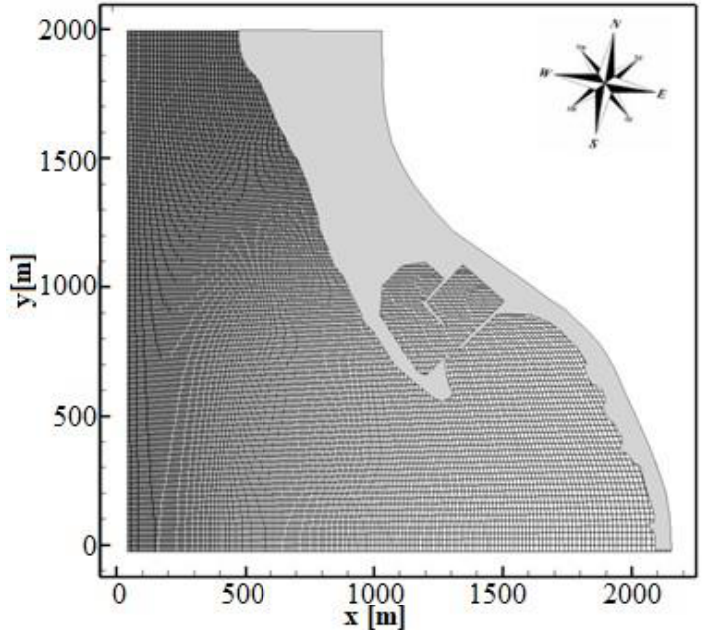
Figure 7. Plan view of the boundary conforming curvilinear grid adopted for the numerical simulation in the present configuration. One curvilinear coordinate line out of 6 is shown.